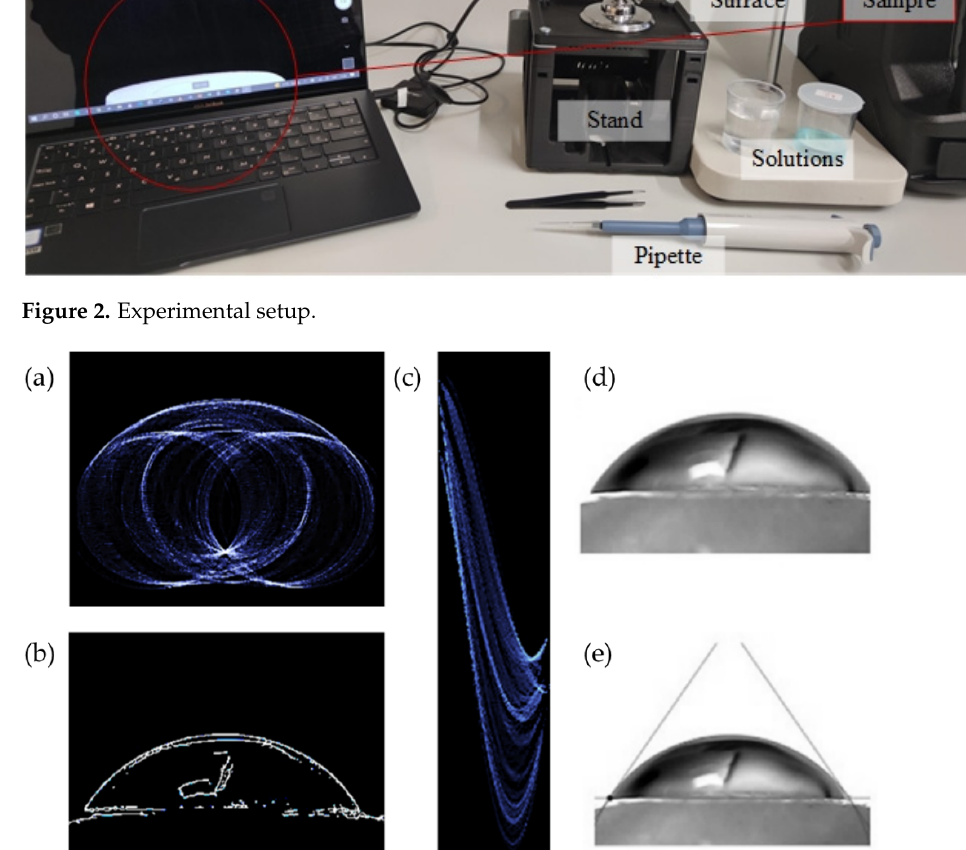
Figure 3. ( a ) Image of the Hough transform for circle detection applied on edge image; ( b ) edge image; ( c ) image of the Hough transform for line detection applied on edge image; ( d ) input image ( e ) output image with angles drawn.